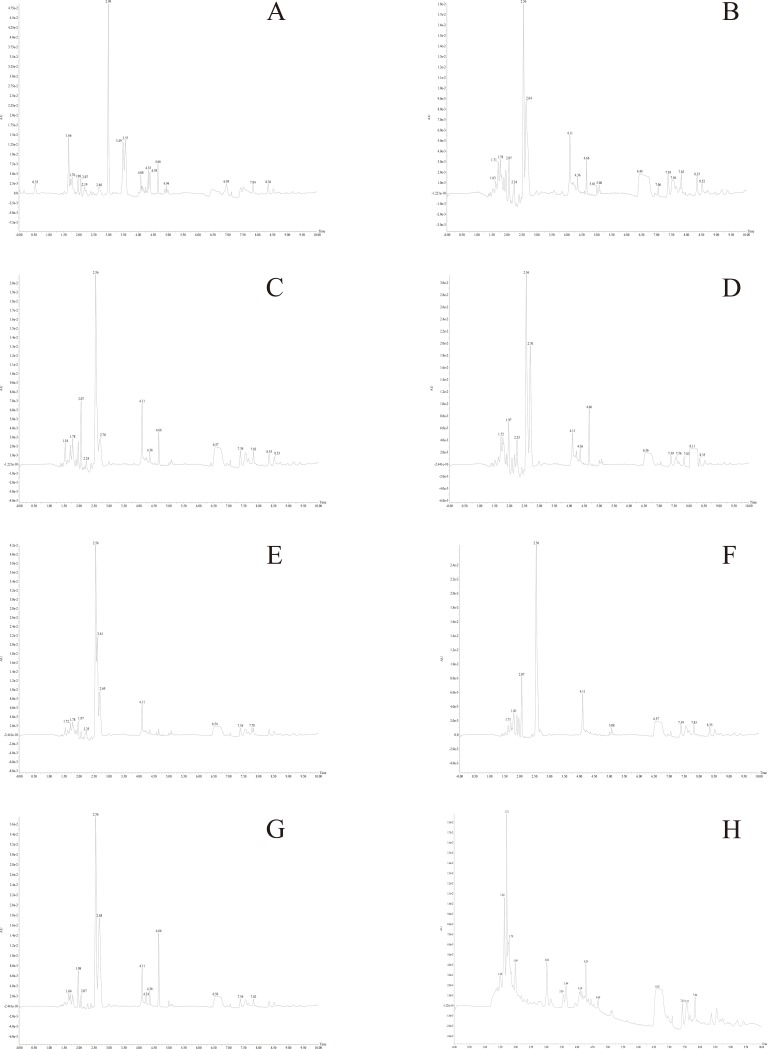
Ultraviolet absorption spectroscopy of all the samples.